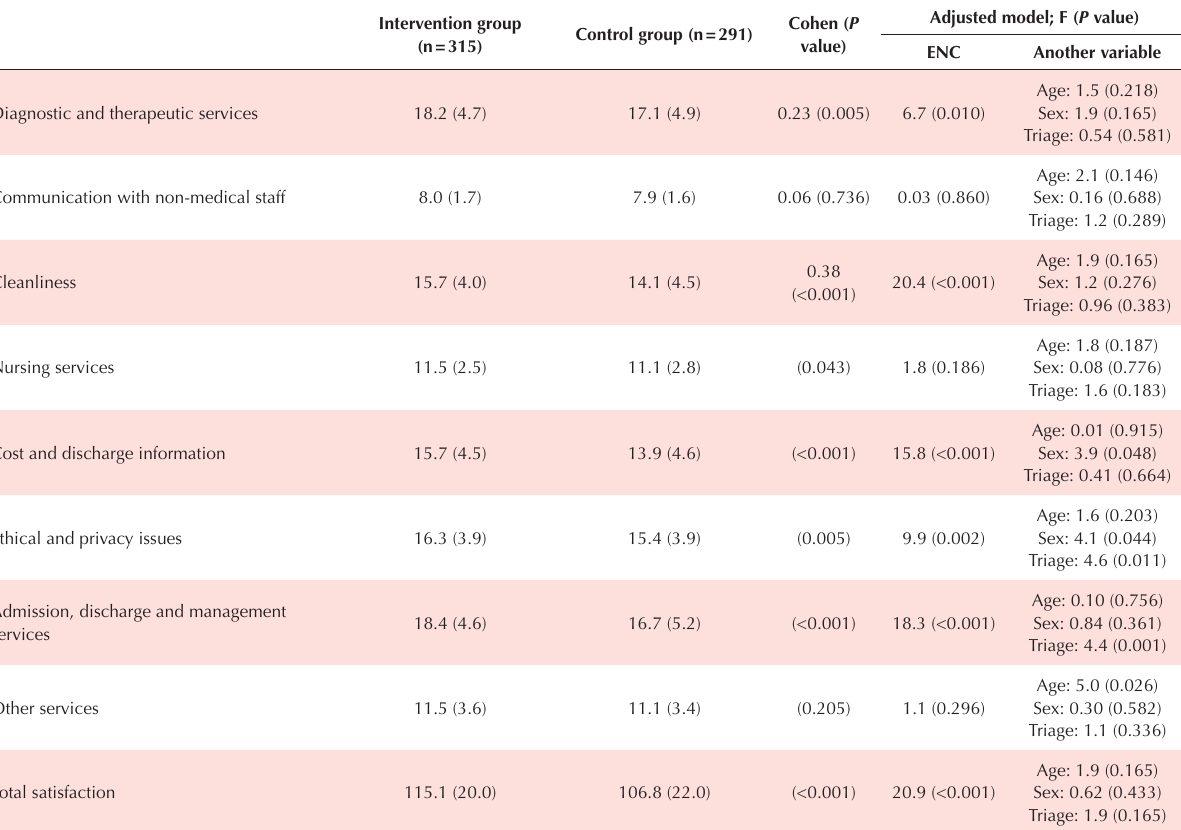
Table 2. The mean difference of satisfaction score between the intervention and control groups in unadjusted and adjusted model